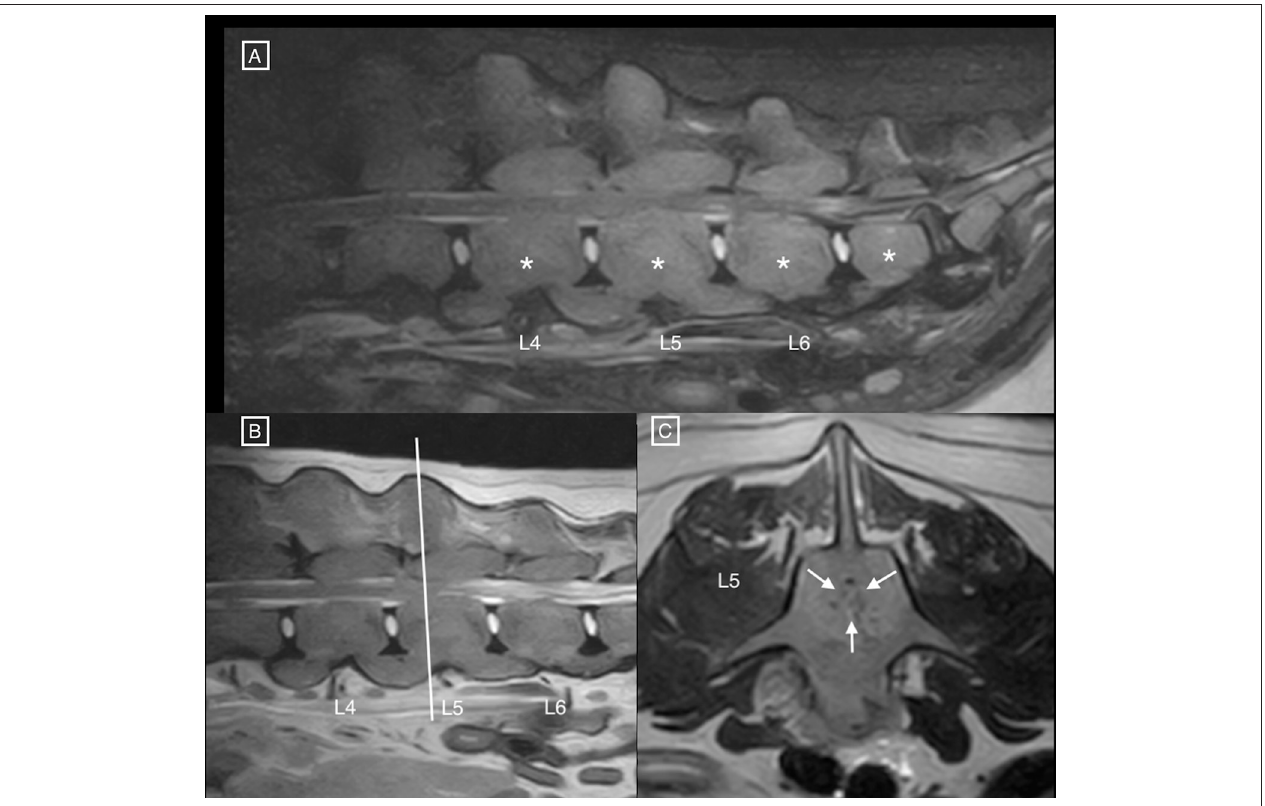
FIGURE 1 | (A) Sagittal STIR and (B) T2 MR images of the lumbar spine, and (C) transverse T2 MR image at the level of mid-L5. Notice the diffuse hyperintensity of the vertebral structures (asterisks), associated with circumferential concentric bone thickening, and secondary narrowing of the vertebral canal (white arrows) leading to circumferential compression of the spinal cord. The nucleus pulposus is also decreased in intensity at L7–S1, and the annulus fibrosus protrudes dorsally in the vertebral